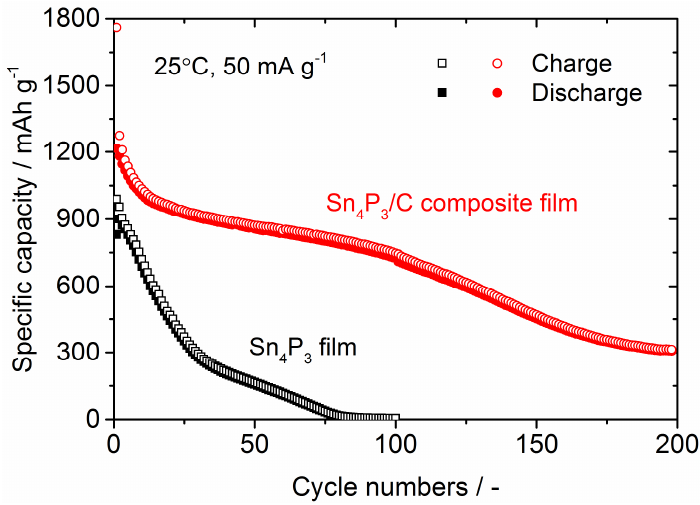
Figure 6. Galvanostatic charge and discharge curves at different cycle numbers for the Sn 4 P 3 /C composite film electrode at 25 ◦ C and 50 mA g − 1 . Cell voltage window for galvanostatic cycling is composite film electrode at 25 °C and 50 mA g −1 . Cell voltage window for galvanostatic cycling is 0– 0–2.5 V. 2.5 V.